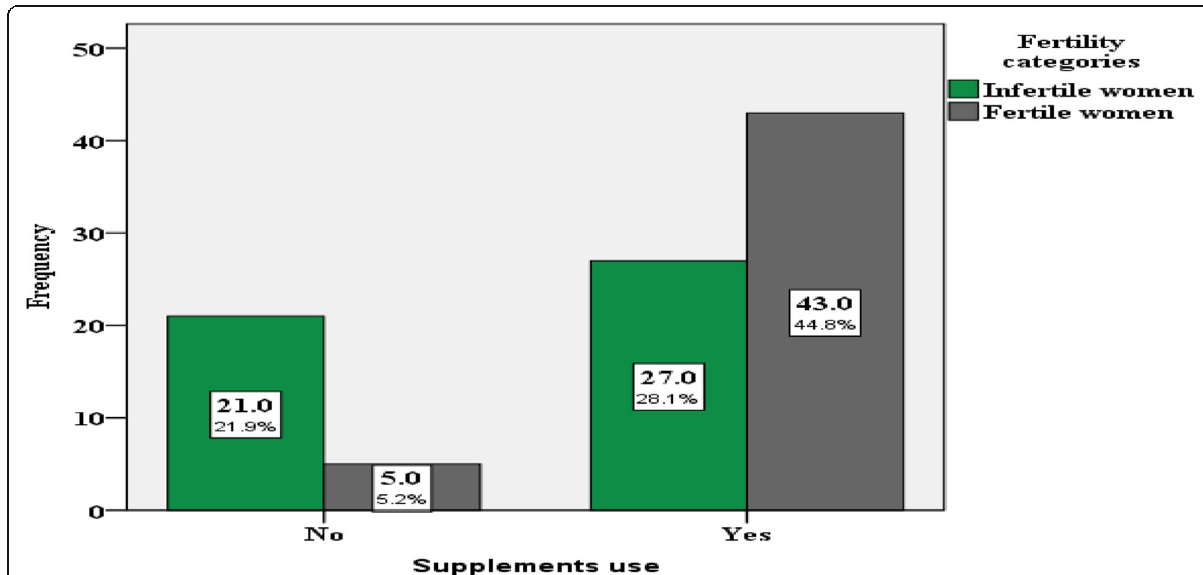
Fig. 2 Bar chart showing supplement use by fertile and infertile women attending MNH, Dar es Salaam, Tanzania